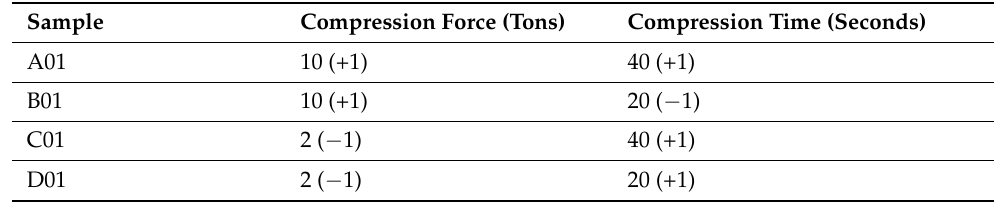
Table 3. Mucin tablets production